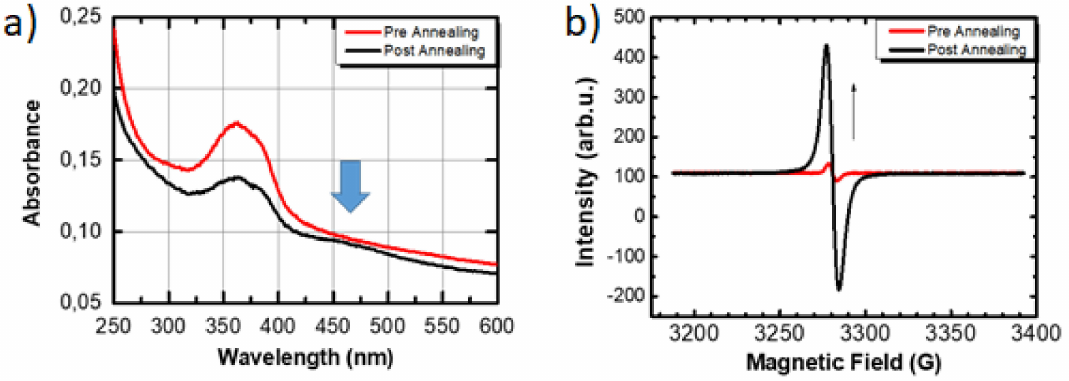
Figure 2. ( a ) UV-Vis absorption spectra of NDI-OH films and ( b ) electron paramagnetic resonance (EPR) pre-annealing (red curve) and post-annealing (black